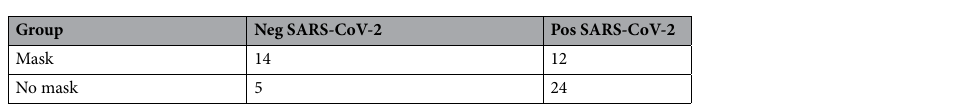
Table 2. Contingency table on the impact of masks a on SARS-CoV-2 transmission. a Medical face masks (community masks and/or surgical masks) or particle filter masks (FFP2, FFP3, KN95).